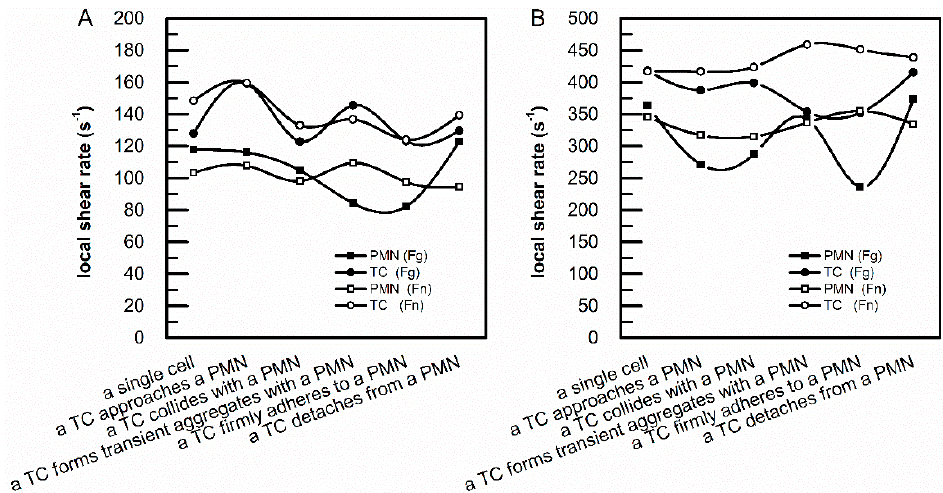
Figure 2. Comparison of local shear rates above adherent PMNs and those above adherent melanoma cells in the presence of soluble fibrin(ogen). A) Under low shear flow condition (91.25 μ L min − 1 ); B) Under high shear flow condition (292 μ L min − 1 ). Solid squares ( ■ ) represent local shear rates above an adherent PMN in soluble fibrinogen (sFg) solution, solid circles ( ● ) represent local shear rates above an adherent TC in soluble fibrin (sFn) solution, open squares ( □ ) represent local shear rates above an adherent PMN in sFg solution, and open circles ( ○ ) represent local shear rates above an adherent TC in sFn solution.